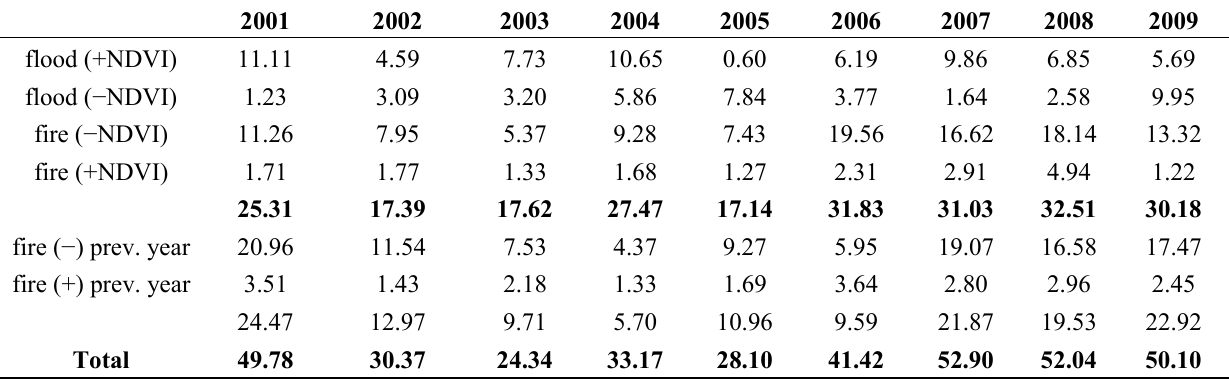
Figure 8. Spatial patterns of standardized g.s. NDVI values for CRB for four years representative of each of the four mean-variance plot sectors identified in Figure 6b and their spatial association with the flooding and fire extents for each of these years. Table 1. Results of the spatial coincidence analysis between higher and lower vegetation productivity (represented in the table as +normalized difference vegetation index ((+NDVI) and − NDVI respectively)) expressed as a standardized NDVI score and individual year flooding extent and current and previous year area burned (expressed as percent of the total area in Chobe River Basin